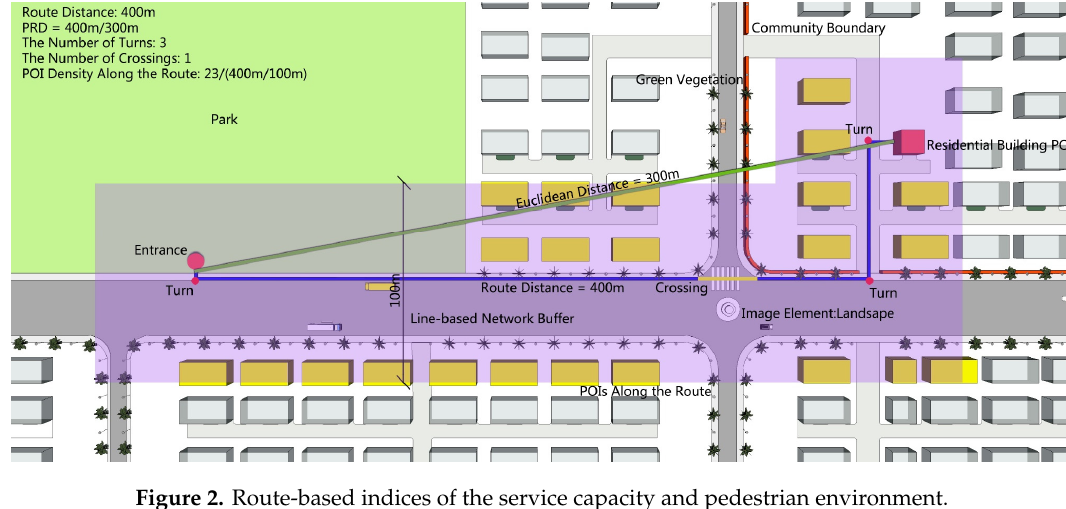
Figure 2. Route-based indices of the service capacity and pedestrian environment.